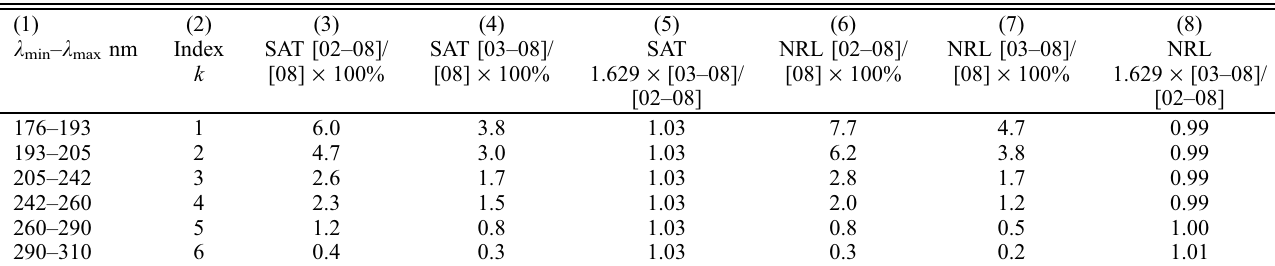
Table 2. The percentage change in flux in each wavelength band of SATIRE-S (abbreviated as SAT) and NRLSSI (NRL) between October 2002 (abbr. 02) and December 2008 (abbr. 08) (columns 3 and 6) and June 2003 (abbr. 03) and December 2008 (columns 4 and 7). The scaling factor to estimate the solar cycle change per 100 SFU in 2002, relative to 2008, based on the F10.7 cm radio flux in 2002, 2003 and 2008, is 1.629. The ratio of the rescaled fluxes to 2002 from between 2003 and 2008, in each band compared to the actual fluxes reconstructed by the models between 2002 and 2003 is given for SATIRE-S and NRLSSI in columns 5 and 8,